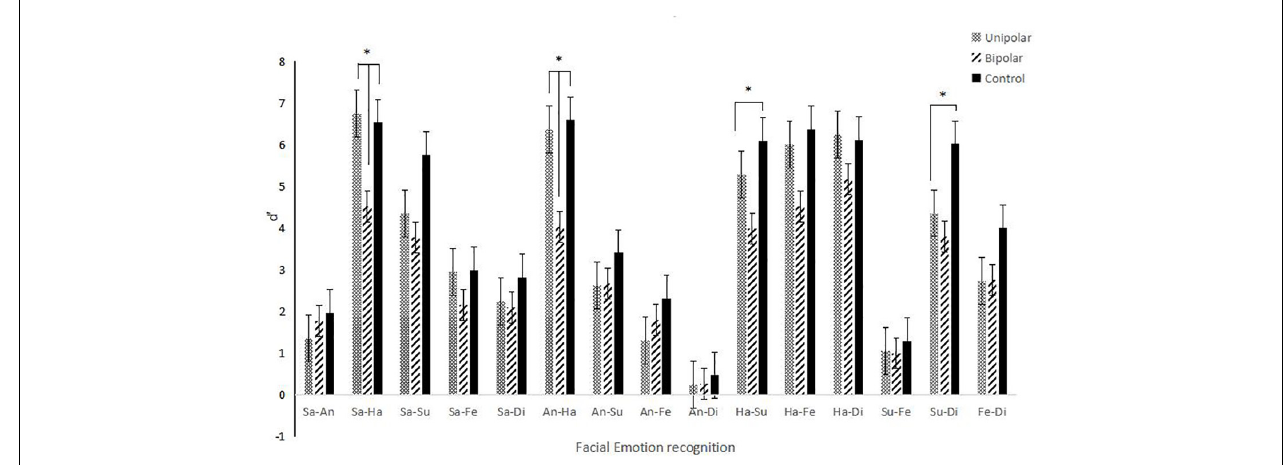
FIGURE 3 | React time of facial expression recognition. Note: “*” represents p < 0.05. “__” represents differences between two groups or among three groups.